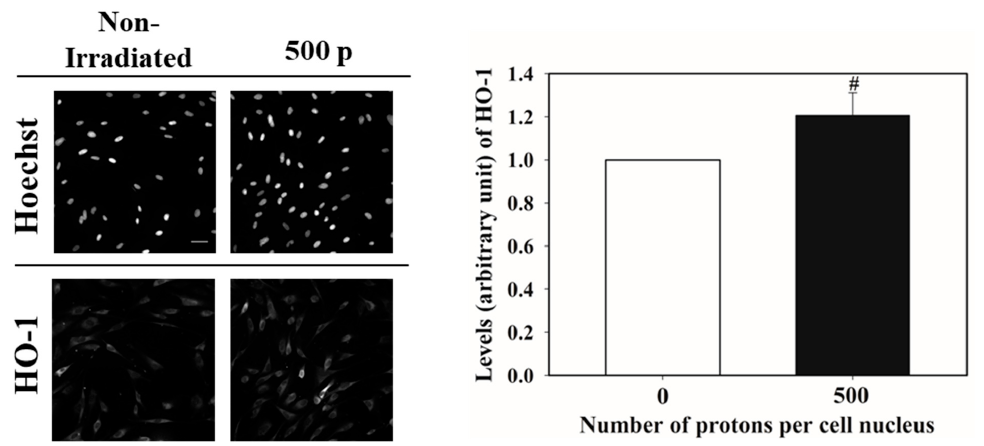
Figure 2. The 500 protons were irradiated at the nucleus of the WI-38 cells. Cellular HO-1 levels were detected by immunofluorescence staining 12 h later. Scale bar = 50 µm. # P value < 0.05.